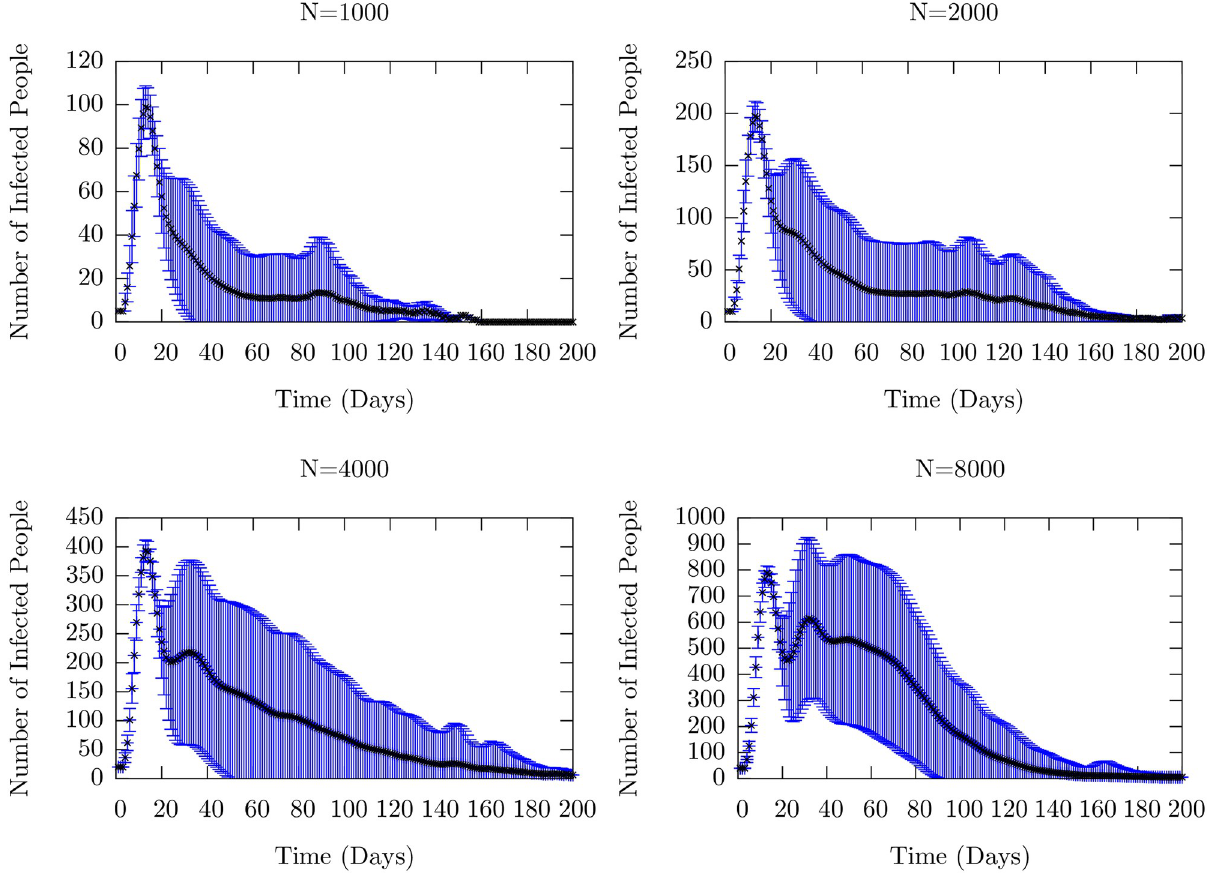
Fig 9. Mean number of infected (the sum of exposed and infectious) people as a function of time for four different total population sizes, all with the parameters given in Table 1. The black dots represent the ensemble average taken at each time point, with the error bars representing the ensemble standard deviations. Individual runs for each of these setups are shown in S7 Fig. We observe the increasing stability of recurrences as the population grows through the the second peak which arises as N is increased. For low values of N , (1000 and 2000), stochastic population collapse occurs frequently enough that there is only one well-defined peak due to the initial infection. The averages are taken over 10,000 individual